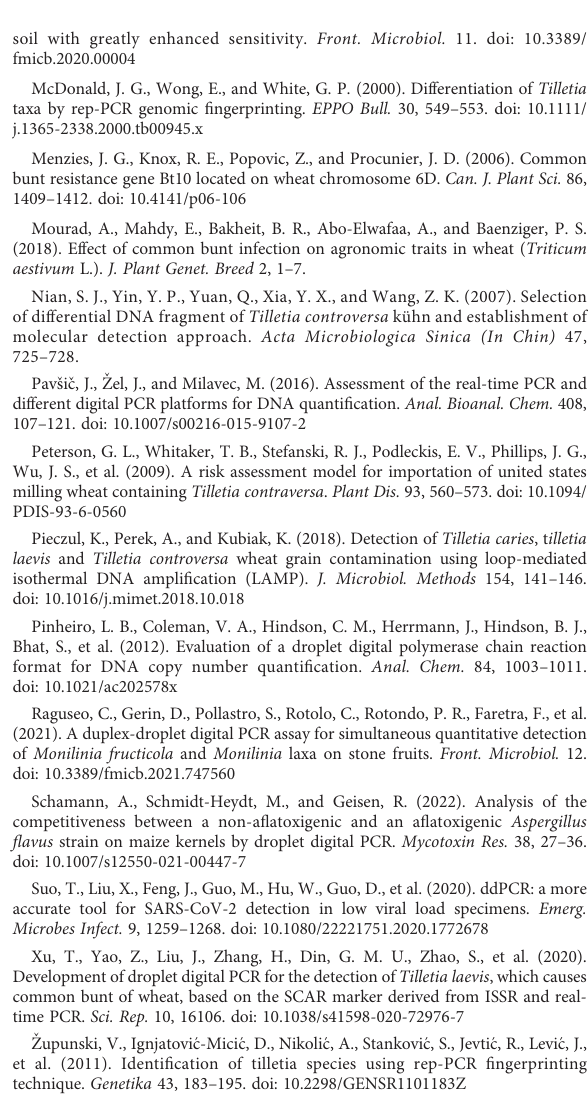
SUPPLEMENTARY FIGURE 1 Speci fi city of quantitative real time PCR detection method. Lanes 1: DNA of T. caries ; lane 2: DNA of T. laevis and T. controversa SUPPLEMENTARY FIGURE 2 Ampli fi cationof T.controversa and T.laevis .A02-H02, DNAtemplateof T. controversa ; A03-B03, ddH 2 O; A04-G04, DNA template of T.